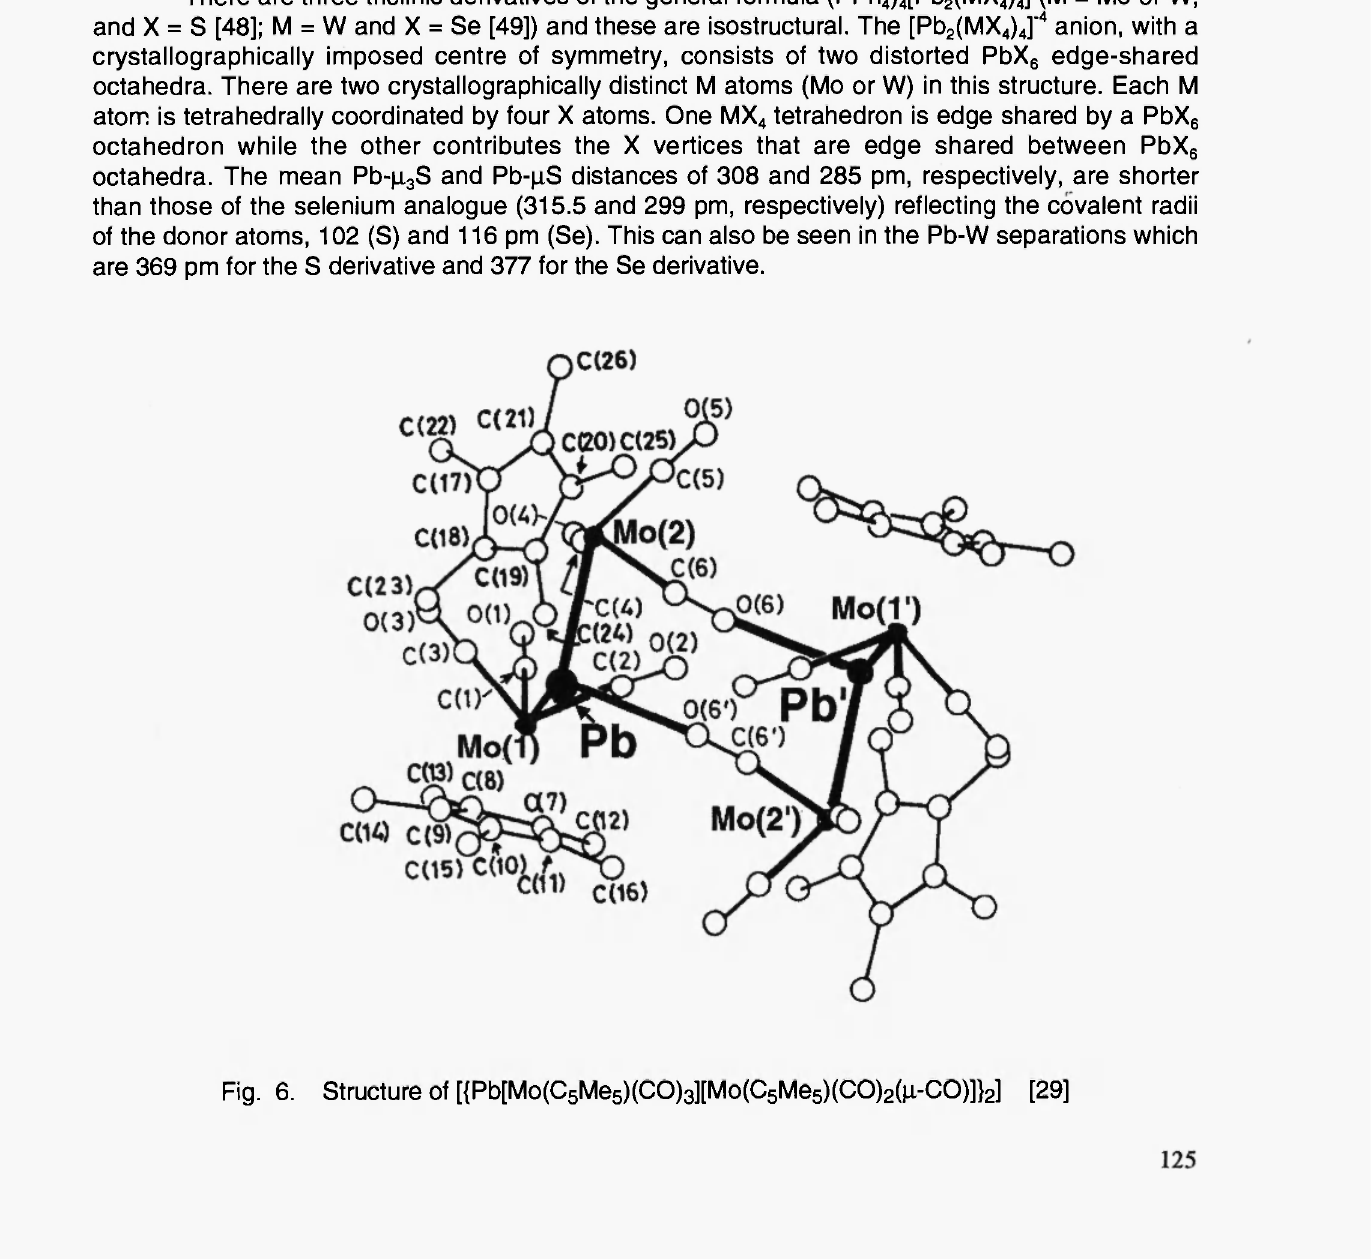
Fig. 6. Structure of [{Pb[Mo(C 5 Me5)(CO)3][Mo(C5Me5)(CO)2^-CO)]} 2 ]